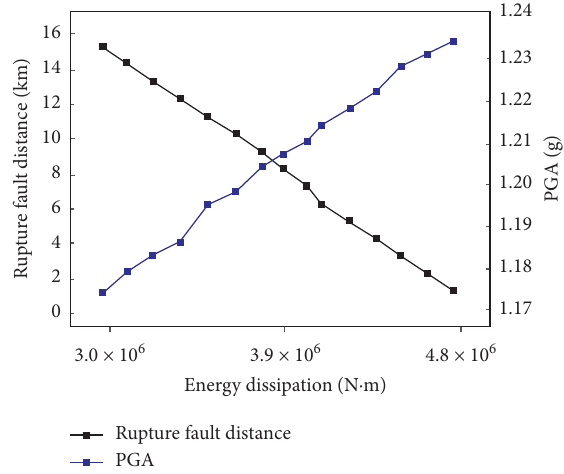
Figure 8: Embankment seismic damages of the 27th combination (F R � 1km (PGA � 1.233g and ε max � 0.2687). (b) Seismic damages of R � 4km (PGA � 1.221g and ε max � 2.0836). (c) Seismic damages of R � 7km (PGA � 1.209g and ε max � 1.9533). (d) Seismic damages of R � 10km (PGA � 1.197g and ε max � 1.8075). (e) Seismic damages of R � 13km (PGA � 1.182g and ε max � 1.6656). (f) Seismic damages of R � 15km (PGA � 1.173g and ε max � 1.5447).